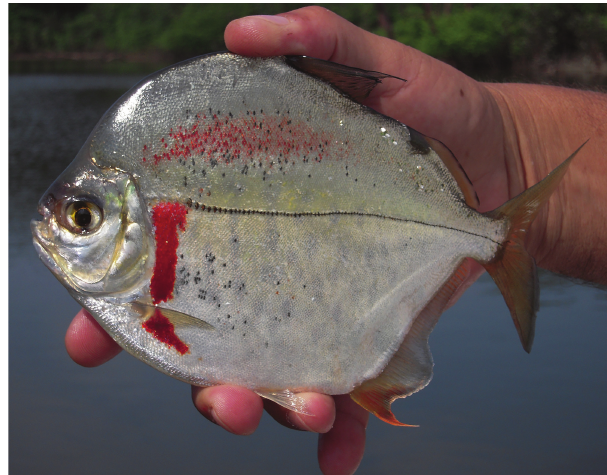
Fig. 7. Freshly collected Metynnis melanogrammus , male, not-preserved; lago do Aracu, rio Sucunduri, rio Madeira basin. Photo: A. Zenaid.